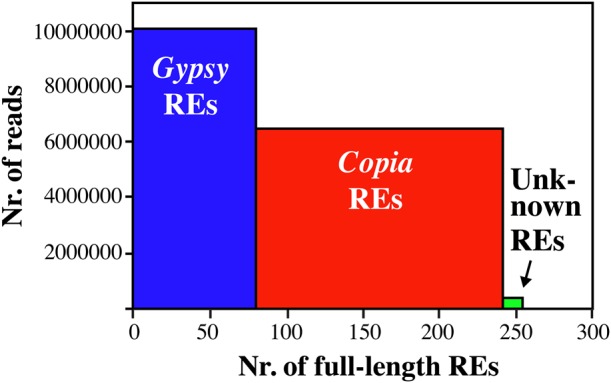
Number of full-length REs identified in this study, separated according to their superfamily. Each bar in the histogram shows the number of Illumina reads that matched to all REs (height) and the number of REs (width) of each superfamily.